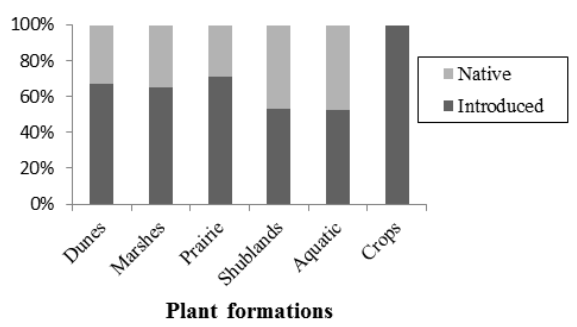
Figure 4. Origin spectrum of the flora of each plant formation determined in the work